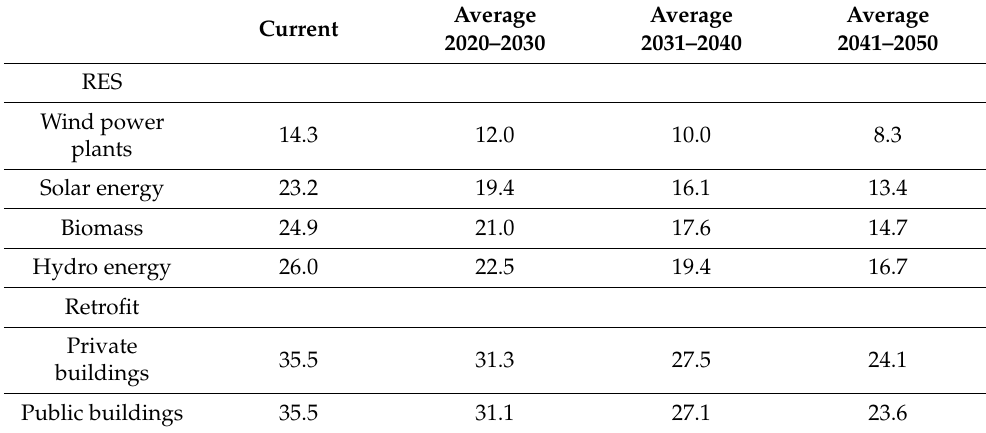
Table 3. Expected employment effects per EUR 1 million investment by periods.